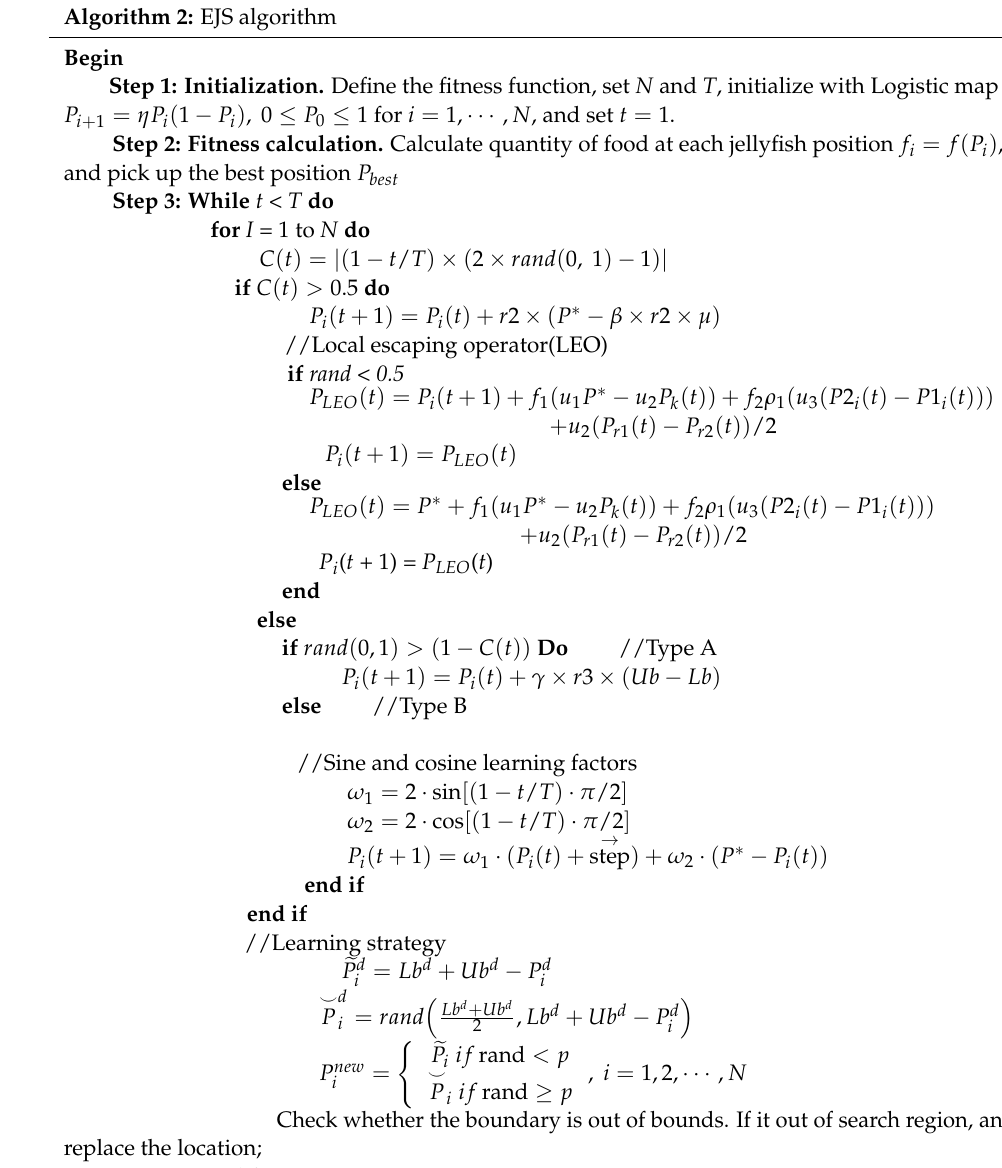
Algorithm 2: EJS